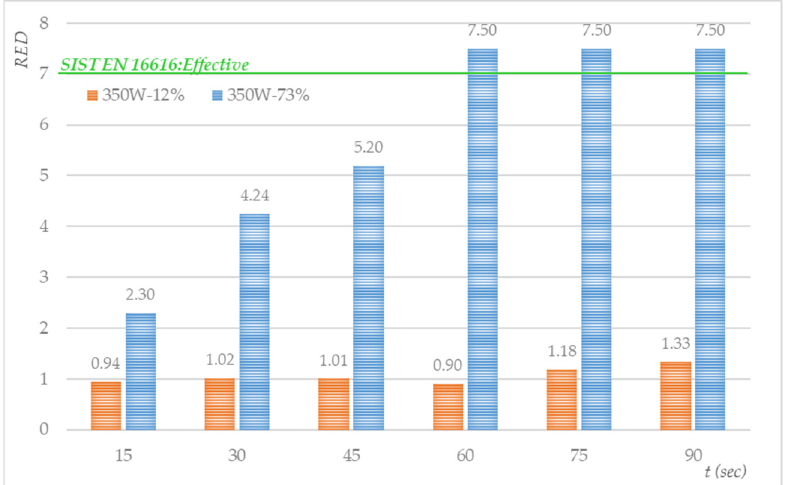
Figure 6. Antimicrobial efficiency of the microwave treatment of cotton swatches inoculated with S. aureus ( N 0,350W,73%MC = 3.14 × 10 7 CFU/mL, N 0,350W,12%MC = 1.36 × 10 7 CFU/mL).